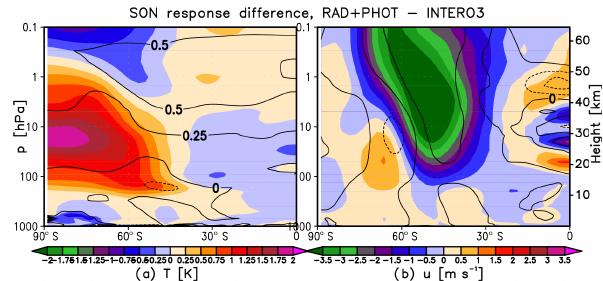
Figure 6. As in Fig. 5 but for the SON